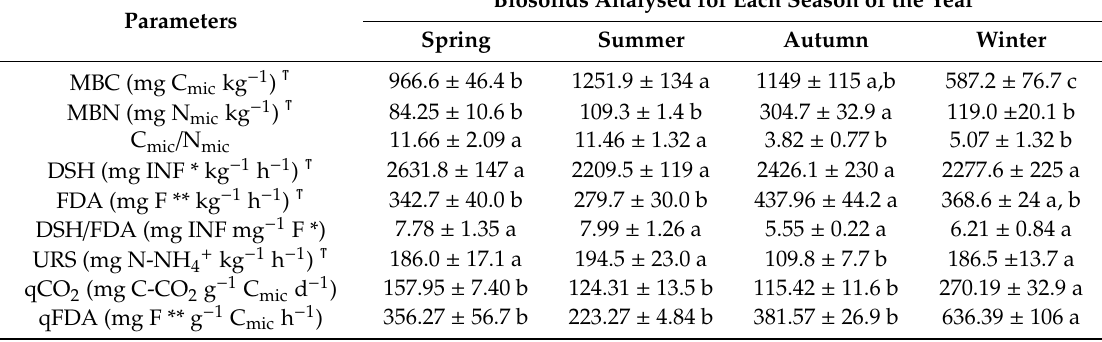
Table 3. Biological characteristics in biosolids collected and evaluated in the UWWTP at di ff erent season of the